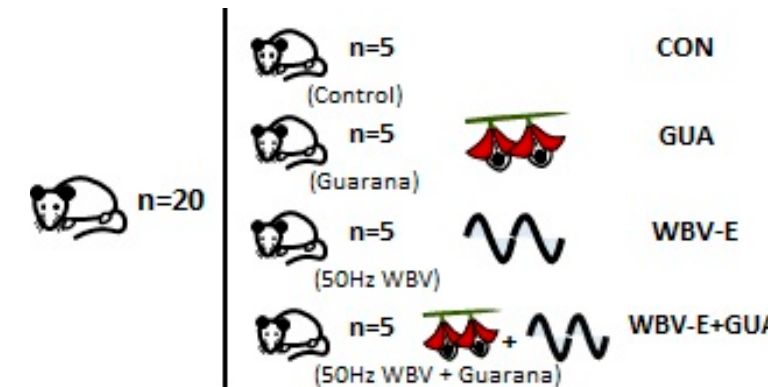
Figure 2. Experimental design for 6-weeks of treatment. Wistar rats (male, n = 20) were randomly divided into (CON) control; (GUA) group treated with guarana; (WBV-E) group exposed to mechanical vibration generated in platform; and (GUA + WBV-E) group treated with guarana and exposed to mechanical vibration.